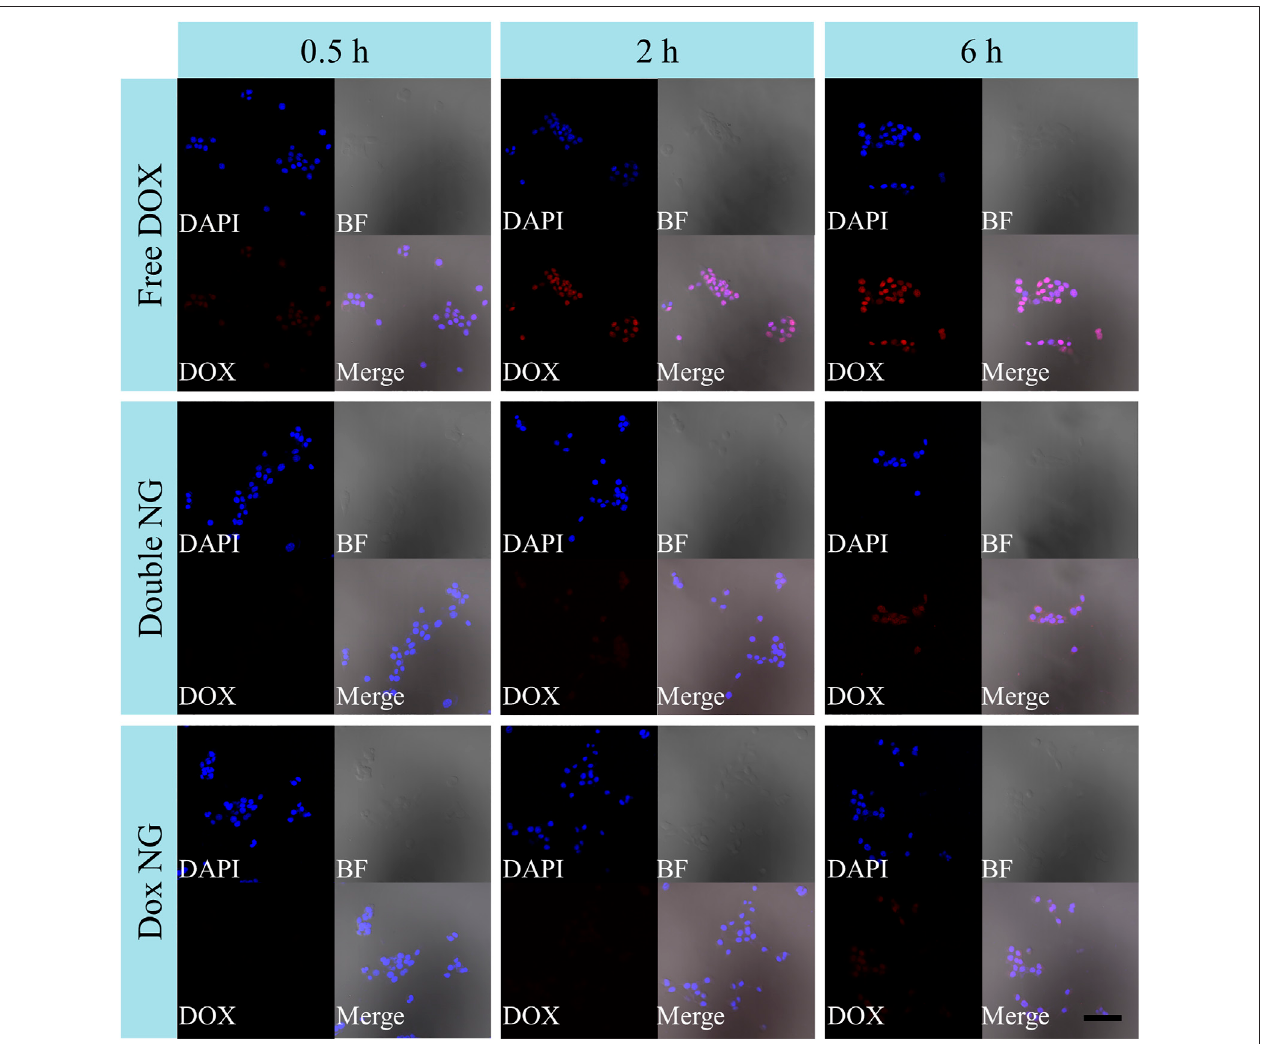
FIGURE 5 | Endocytosis experiment. The CLSM microimaging analyses for cell endocytosis of Free DOX, DOX/Ola NG, and DOX NG. The blue channel is DAPI nuclear staining, the red channel is DOX staining, and the gray channel is bright fi eld. The scale bar is 100 μ m.